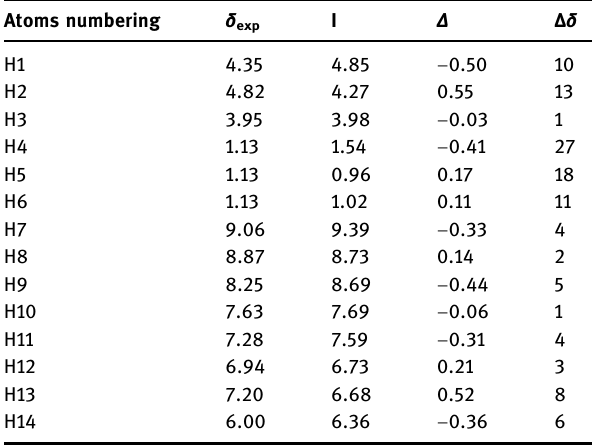
Table 9: Experimental ( δ exp ) and calculated chemical shifts ( II )